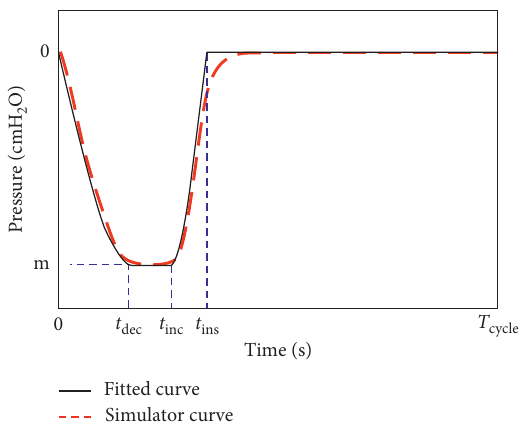
; the black solid line represents the mus , max